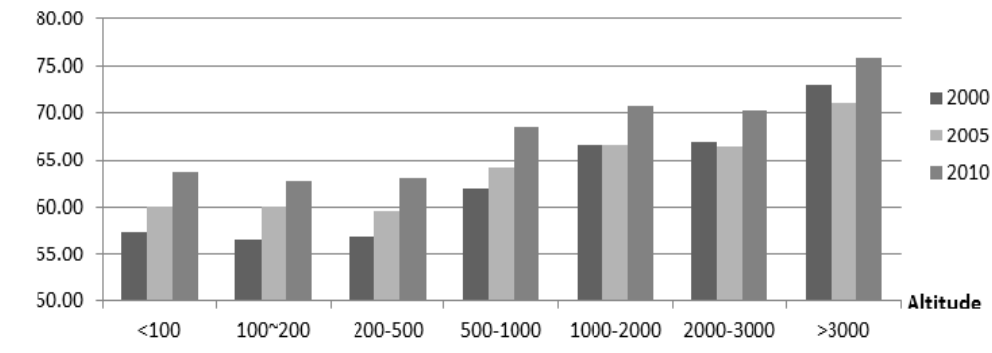
Table 3. Carbon densities at different altitudes.